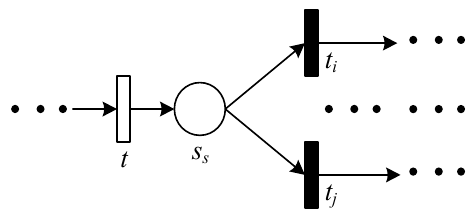
Figure 4. The competitive structure.